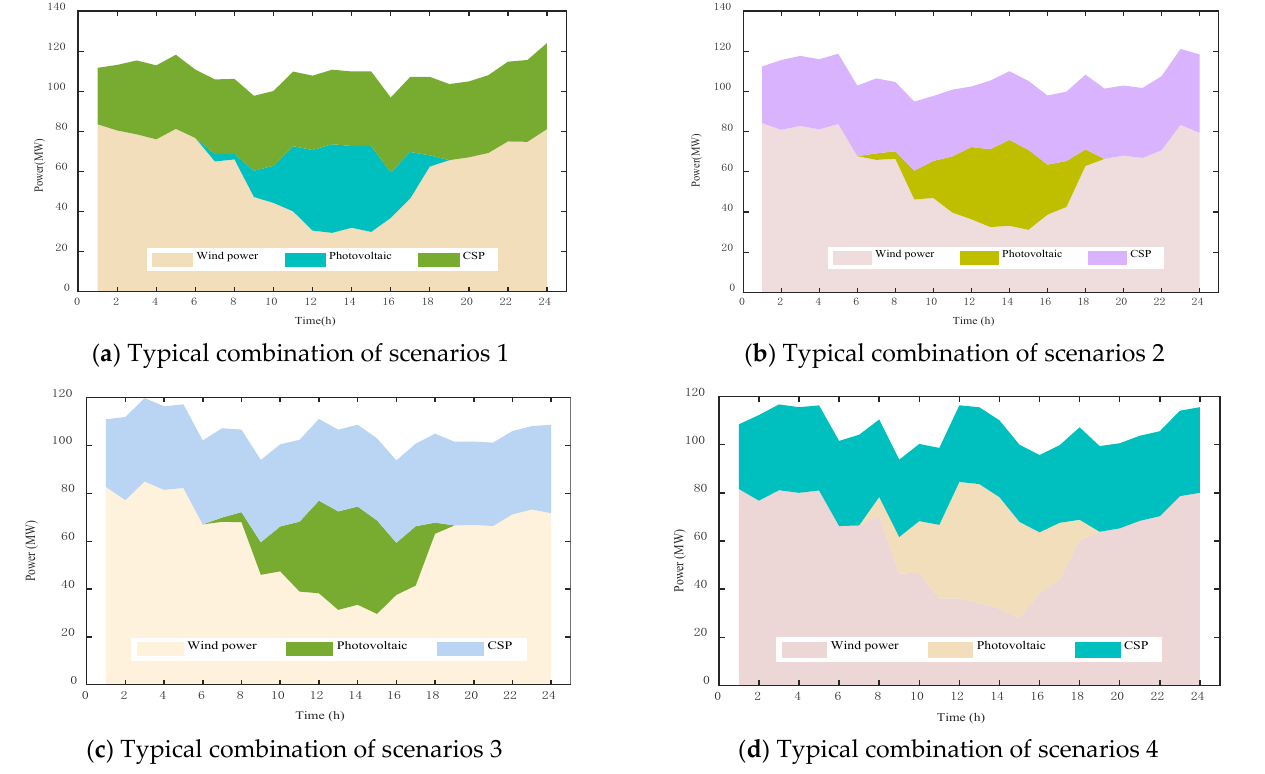
Figure 6. Optimal outputs of wind power, photovoltaic power, and CSP under four typical combinations of scenarios.